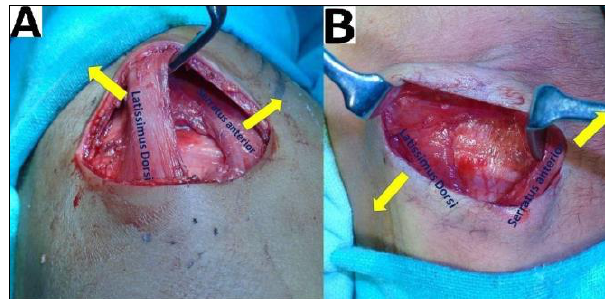
Figure 1. Intraoperative photographs showing: (A) muscle-sparing thoracotomy with Latissimus Dorsi being retracted laterally (by retractors) and belly of the serratus anterior retracted medially; (B) post-dissection and before entering the rib cage.